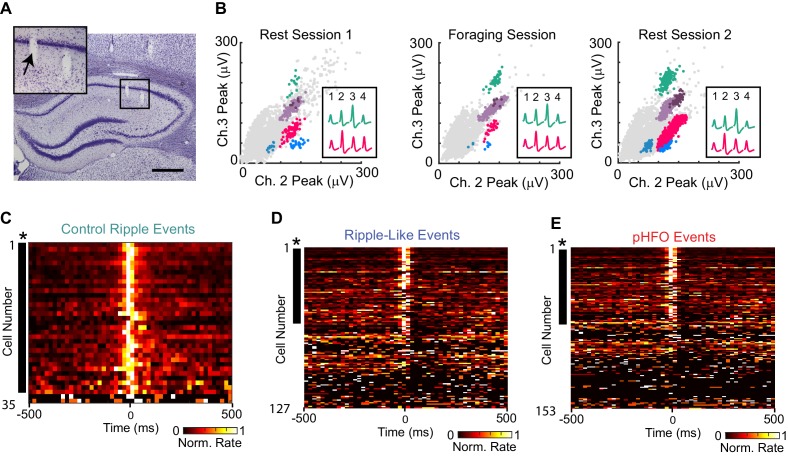
CA1 principal neurons increase firing rates during control ripple, ripple-like events, and pHFOs.(A) Coronal section through the area of the hippocampus with tetrode tracks in the CA1 area. The area in the black box is magnified in the inset on the upper left. The tetrode position for the spike recordings in (B) is indicated by an arrow. Scale bar, 300 µm. (B) Scatterplots of spike amplitudes on two of the four recording channels (ch2, ch3) from the tetrode identified in (A). Each colored cluster corresponds to spikes from one cell, and insets show average waveforms of two well-isolated cells. Noise spikes are shown in grey. The similarity of the scatterplots and waveforms across the rest and foraging epochs indicates that the same cells were reliably recorded throughout the session. For more details about single unit sorting, see Figure – Supplement 1.( C) Each row in the heat map is the average rate vector for an individual control CA1 principal neuron aligned to ripple events (time 0). Average rates are normalized to their peak and range from 0 (black) to 1 (white). Neurons are sorted by ripple-modulation significance such that strongly modulated neurons are at the top. Neurons that show significant modulation (p <0.05, *) are marked by a black dash to the left of the row. Almost all control neurons are ripple-modulated (91%), and fire maximally during the ripple period (time 0). (D) The same as (C), but for neurons recorded in animals with epilepsy during ripple-like events (left, 46% of neurons were modulated). (E) The same as (C), but for neurons recorded during pHFO events (right, 21% of neurons were modulated). Please note that neurons in (D) and (E) are ordered differently, therefore cell identity across rows are not comparable. For rates and p-values see Figure – source data (1–3, corresponding to C-E).10.7554/eLife.42148.010Figure 4—source data 1.Neuron activity during control ripple.Source data correspond to data shown in panel C. For each neuron (neuron # is a unique identifier given to each single unit in the study) several data are shown: (from left to right) the # of SWR ripples (for control), mean rate during baseline (BL), mean rate during detected high-frequency ripple events, and the p-value obtained using a Wilcoxon signed rank test. Neurons are ordered according to p-value, with the smallest p-values at the top. The solid line separates neurons that significantly changed rate during a high-frequency event from those that did not. Neuronal activity during ripple-like oscillations are reported in Figure 4—source data 2 and during pHFO in Figure 4—source data 3.10.7554/eLife.42148.011Figure 4—source data 2.Neuron activity during ripple-like oscillations.Source data correspond to data shown in panel D. For each neuron (neuron # is a unique identifier given to each single unit in the study) several data are shown: (from left to right) the # of ripple-like oscillations (R–L), mean rate during baseline (BL), mean rate during detected high- frequency R-L events, and the p-value obtained using a Wilcoxon signed rank test. Neurons are ordered according to p-value, with the smallest p-values at the top. The solid line separates neurons that significantly changed rate during a high- frequency event from those that did not. Note that all neurons listed in Figure 4—source data 2 are also in Figure 4—source data 3 (but not vice versa), and can be compared by looking at neuron number.10.7554/eLife.42148.012Figure 4—source data 3.Neuron activity during pHFO.Source data correspond to data shown in panel E. For each neuron (neuron # is a unique identifier given to each single unit in the study) several data are shown: (from left to right) the # of pHFOs recorded, mean rate during baseline (BL), mean rate during detected high- frequency events, and the p-value obtained using a Wilcoxon signed rank test. For each table, neurons are ordered according to p-value, with the smallest p-values at the top. The solid line separates neurons that significantly changed rate during a high- frequency event from those that did not. Note that all neurons listed in Figure 4—source data 2 are also in Figure 4—source data 3 (but not vice versa), and can be compared by looking at neuron number.